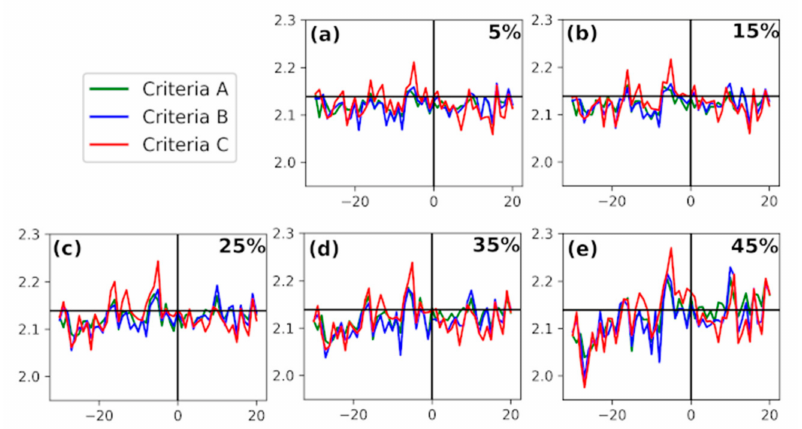
Figure 6. Mean values of minimum night TEC at IGS Noto ( y -axis) through index days ( x -axis) for different daily increase in the volcanic radiative power (VRP) value: ( a ) 5%, ( b ) 15%, ( c ) 25%, ( d ) 35%, ( e ) 45% of daily VRP increase, respectively. Described TEC pattern is visible in all plots with slight differences, as discussed in